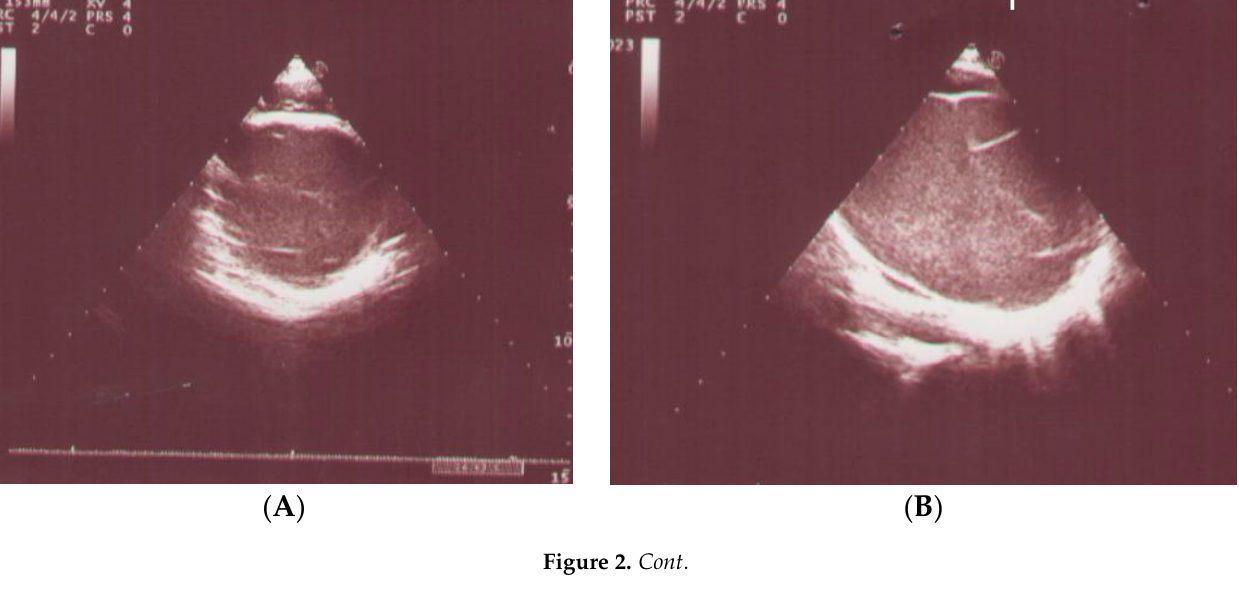
Figure 1. A 9-year-old boy presented with palpitations. Electrocardiography showed sinus tachycardia.